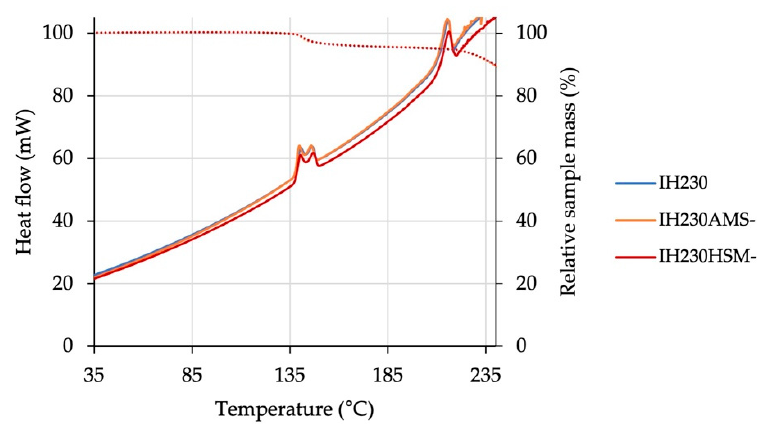
Figure 2. Results of DSC analysis of the raw material in comparison to processed powders without the additive. The secondary y-axis shows the relative mass decrease (dotted lines). n = 3. Negligible variation between the compared data series results in overlapping curves.